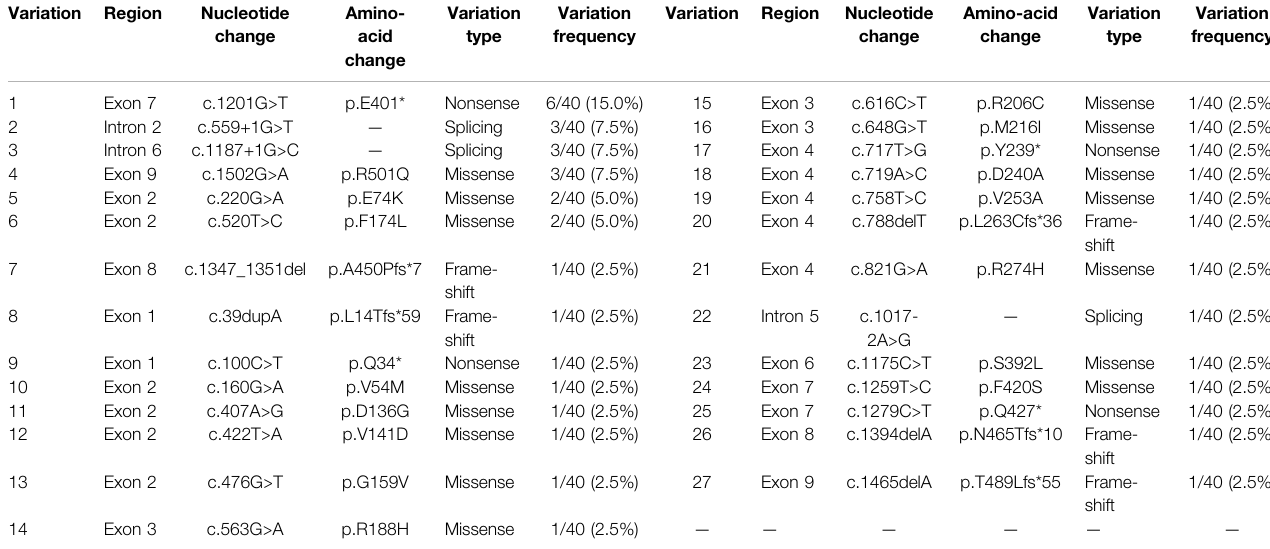
TABLE 3 | The frequency of HMGCS2 variations in 20 unrelated Chinese patients (total number of mutated alleles (cid:1) 40). Variation Region